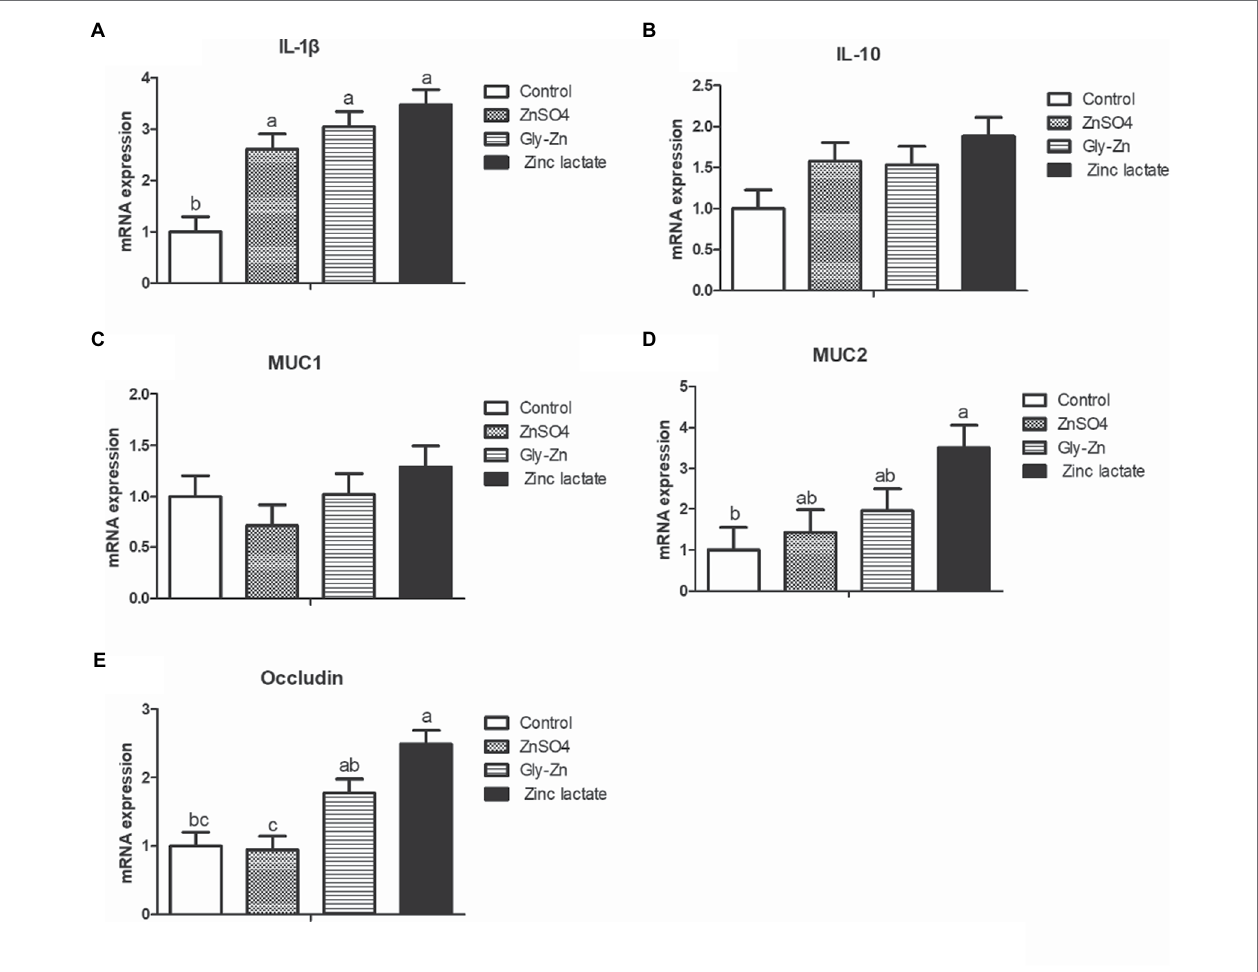
FIGURE 4 | Effect of dietary zinc sources on the relative mRNA expression levels of jejunal barrier-related genes in weaned piglets. Control, basal diet. ZnSO4, basal diet +100 mg/kg zinc sulphate. Gly-Zn, basal diet +100 mg/kg glycine zinc. Zinc lactate, basal diet +100 mg/kg zinc lactate. The relative mRNA expression levels of jejunal interleukin-1 β (IL-1 β ; A) , interleukin-10 (IL-10; B) , mucin 1 (MUC1; C) , mucin 2 (MUC2; D) , and Occludin; E) were determined by real-time quantitative PCR. a,b Within a row, means without a common superscript letter differ ( p <